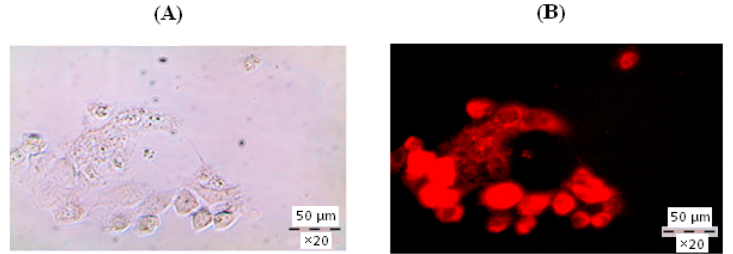
Figure 11. Bright-field ( A ) and fluorescent ( B ) images of Caco-2 cell containing GP3 particles stained with rhodamine 6g.